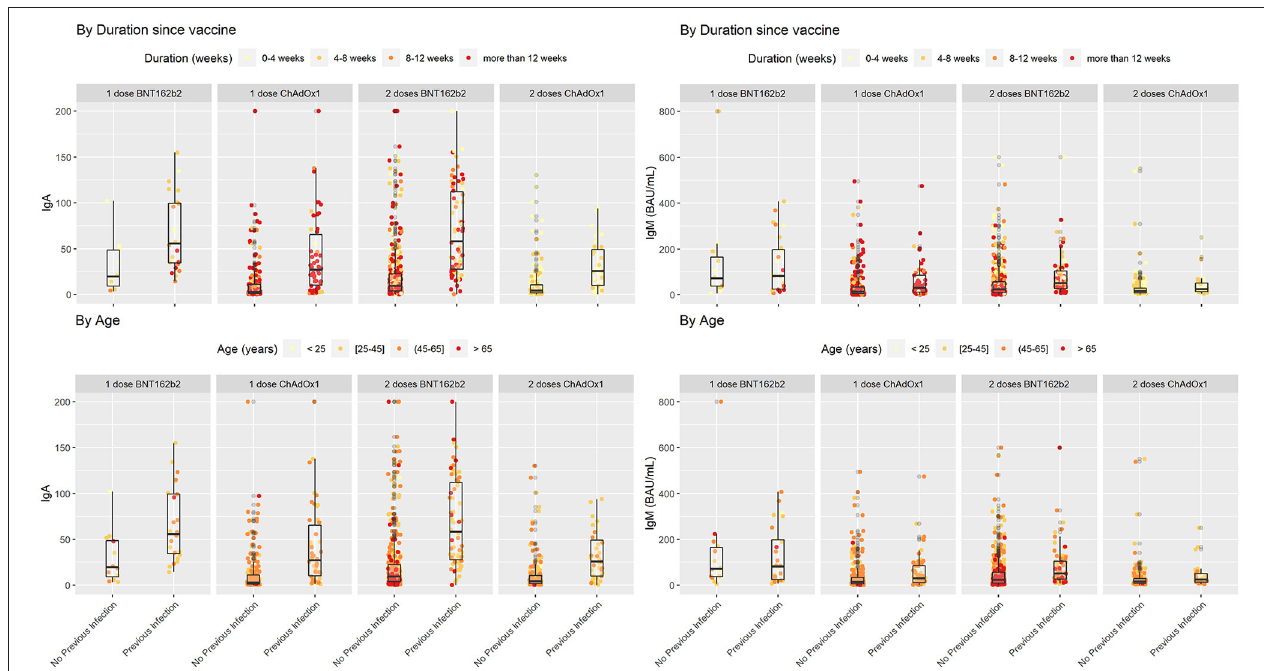
FIGURE 2 | SARS-COV2 IgA and IgM antibodies in vaccinated individuals stratified by previous infection status while duration since vaccination and age variations shown based on color coding. In each subgroup individuals with previous COVID-19 infection showed higher levels of IgA in comparison with their counterparts who did not encounter COVID-19. Lower levels of IgA seem to be associated with a cluster of older individuals who received two doses of BNT162b2 without previous